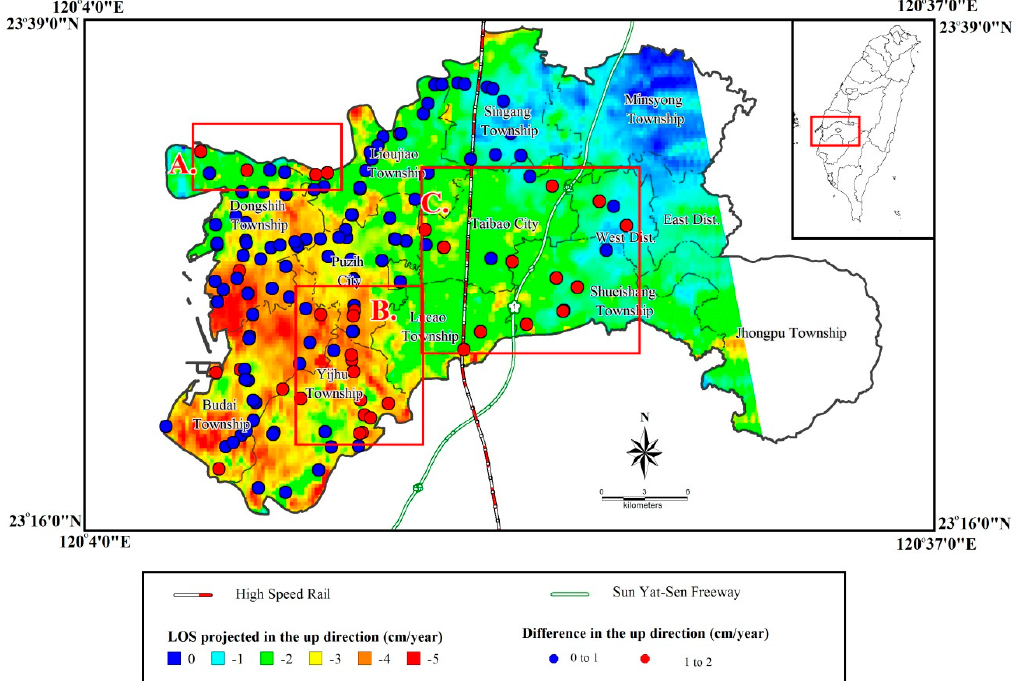
Figure 11. Three blocks classifying the large differences between the vertical displacement rates from InSAR and leveling.